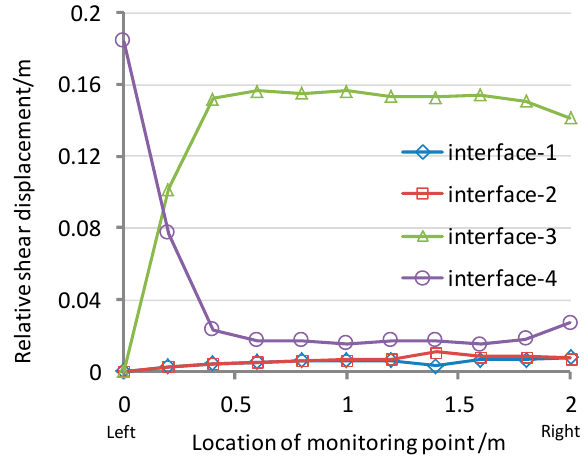
Figure 11. Relative interface shear displacements between different interfaces (Normal stress = 100 kPa).